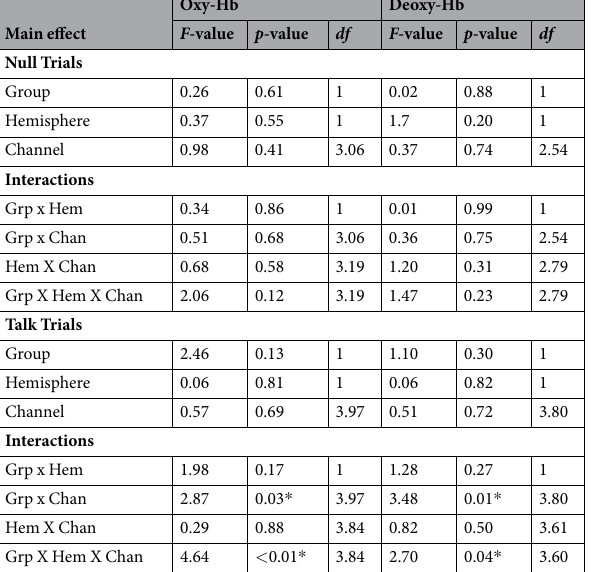
Table 1. Statistical summary of group, hemisphere, and channel effects on hemodynamic responses for null and talk trials from ANOVA. * p ≤ 0.05; df : degrees of freedom. Huynh-Feldt corrected df and p -values are reported when Mauchly’s Test of Sphericity was statistically